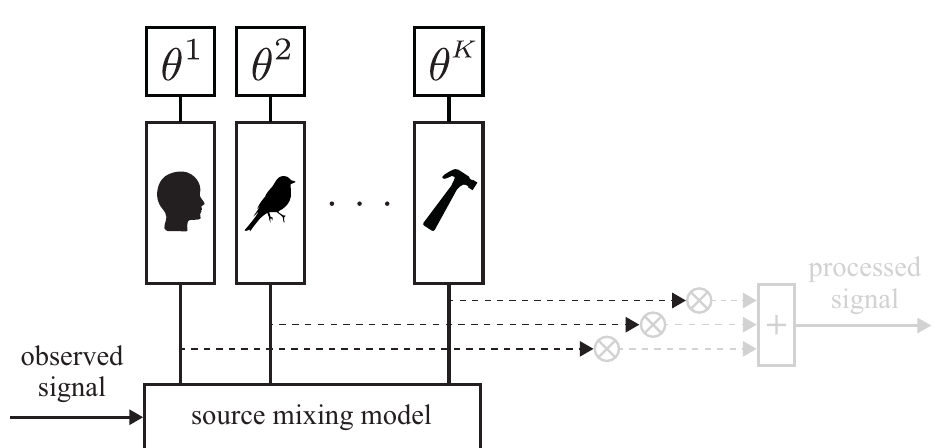
Figure 2. An overview of the source separation stage. Based on the observed signal and the trained source models the latent states corresponding to the individual signal are tracked and extracted.